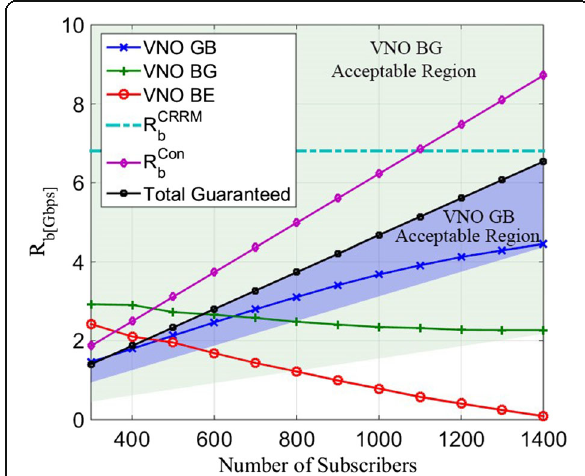
Fig. 6 Variation of the data rate allocated to each